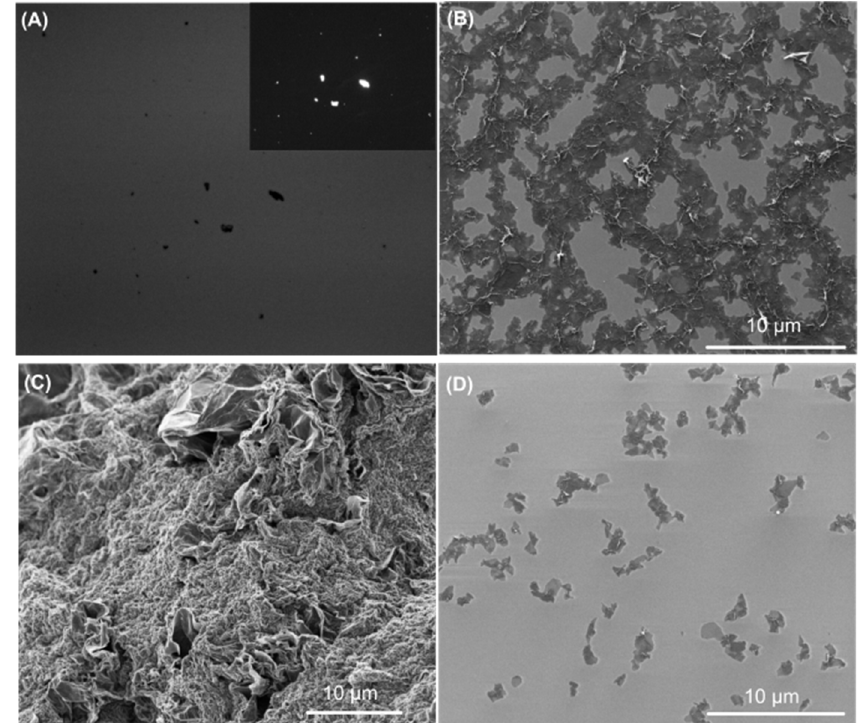
Figure 3. ( A ) Optical and (a, inset) fluorescent microscopy images of dried GO/Zn (OAc) 2 /PA-PDI hybrid material. SEM microphotographs of ( B ) GO/Zn (OAc) 2 /PA-PDI hybrid material, ( C ) GO/Zn (OAc) 2 /glu-PDI hybrid material, and ( D ) GO/PA-PDI composite.